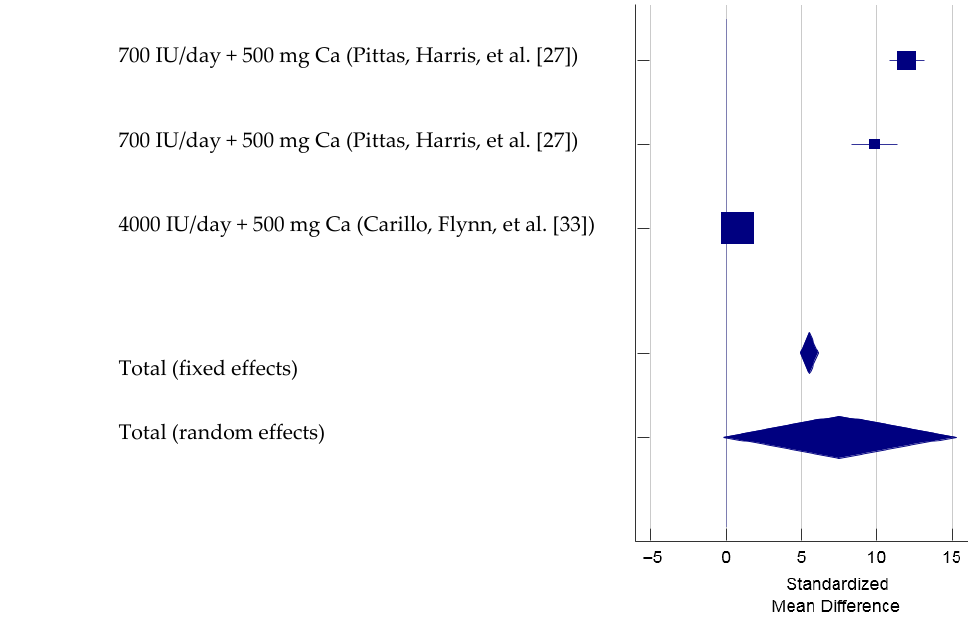
supplementation. Note: Pittas et al., 2007 study included two separate study groups, once